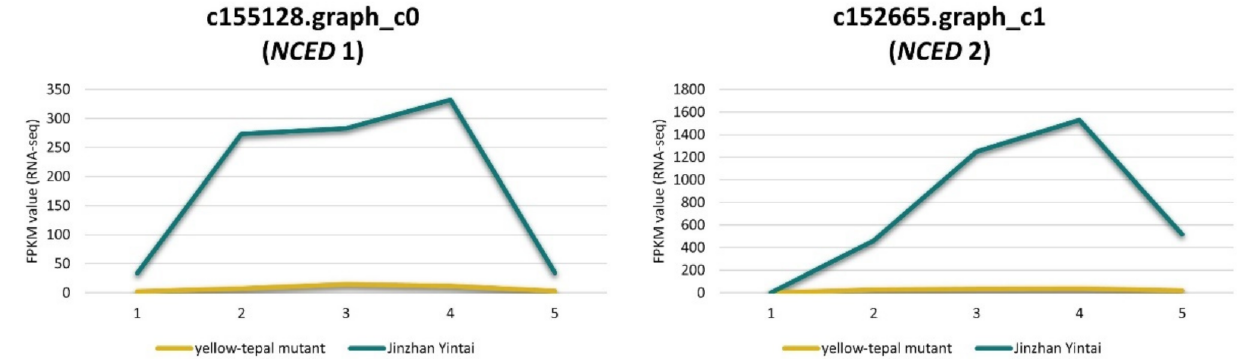
Figure 8. Expression levels of NCED genes in ‘Jinzhan Yintai’ and its yellow mutant. The yellow line represents the expression level of the gene in the yellow mutant, while the green line represents the expression level of the gene in ‘Jinzhan